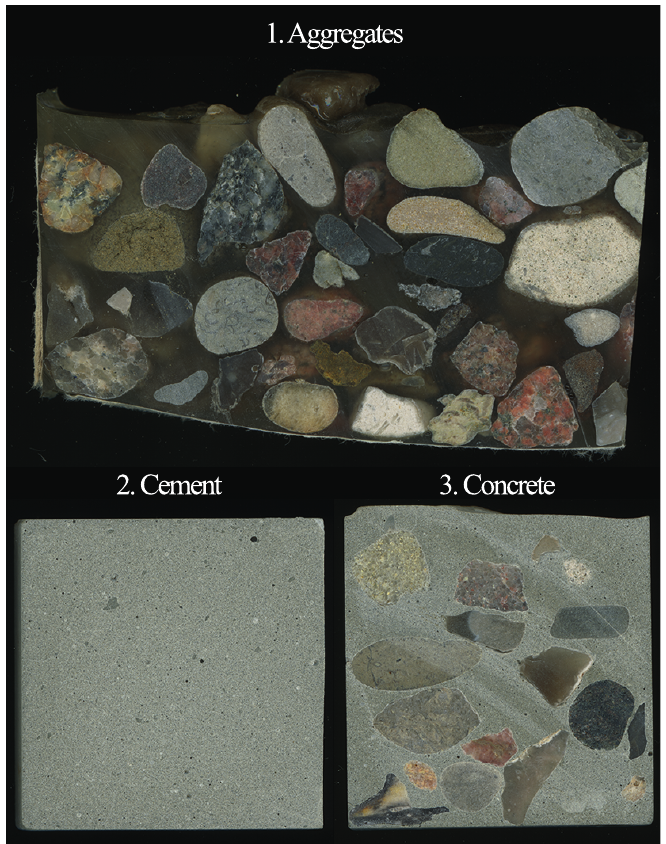
Figure 2. The three sample types used for